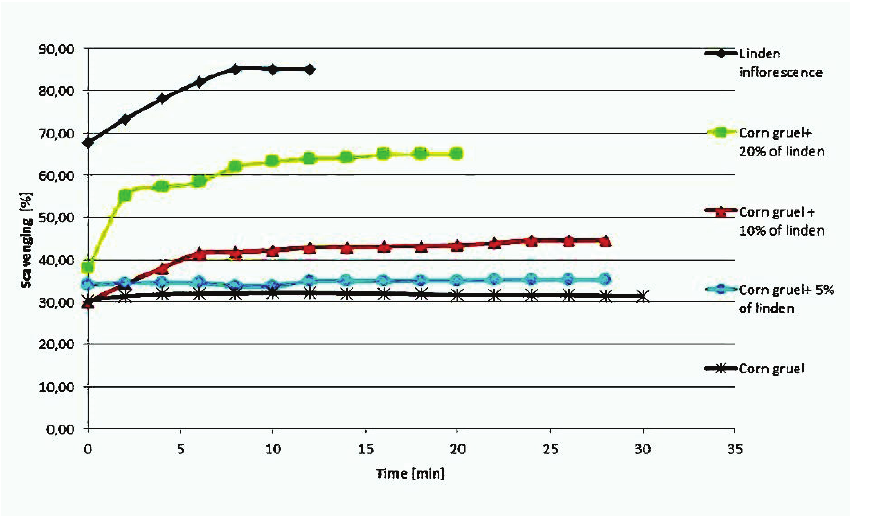
Figure 2: Free radical scavenging activity of extract of linden inflorescence, gruels with 5, 10, 20% addition of linden inflorescence and corn grit towards DPPH • in